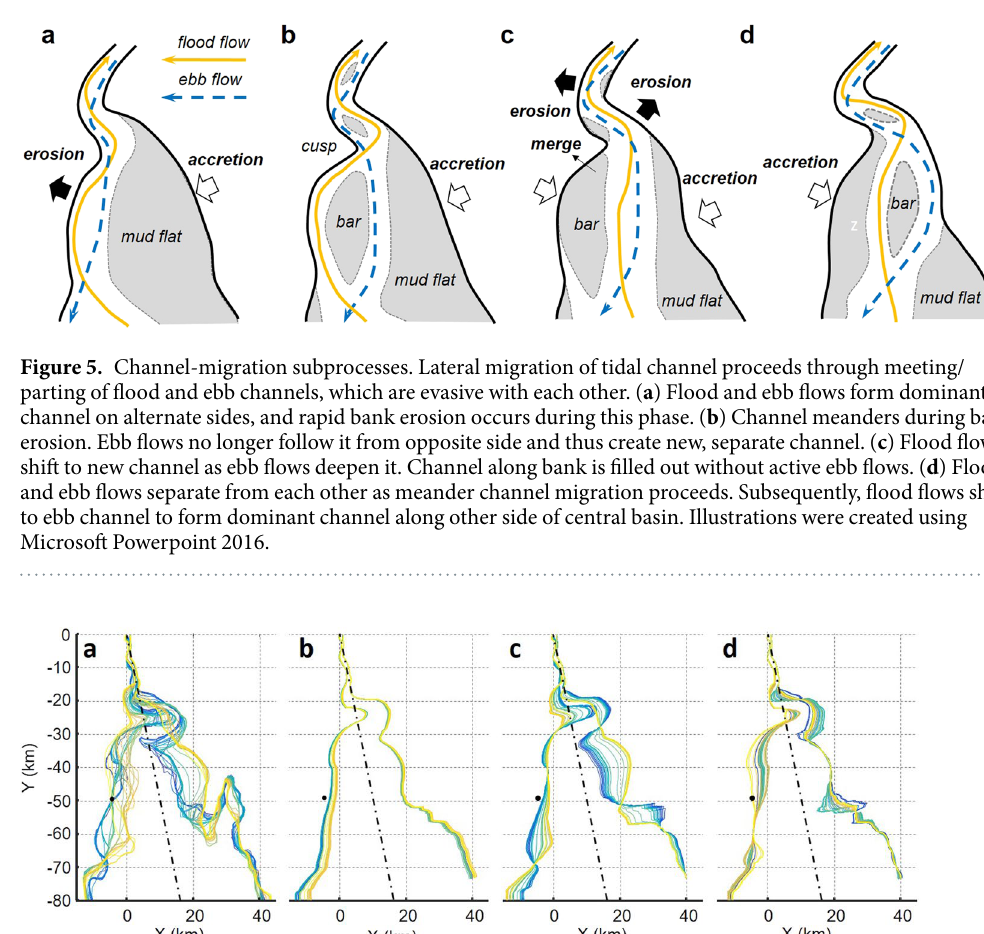
evolution. Both the upper channel and the central basin are filled with a tight meander, while active channel migration sweeps sediments out from the central basin with a cuspate meander. The estuary infilling likely pro- ceeds with the downshift of the transitional segment through the destruction and creation of tight meanders.